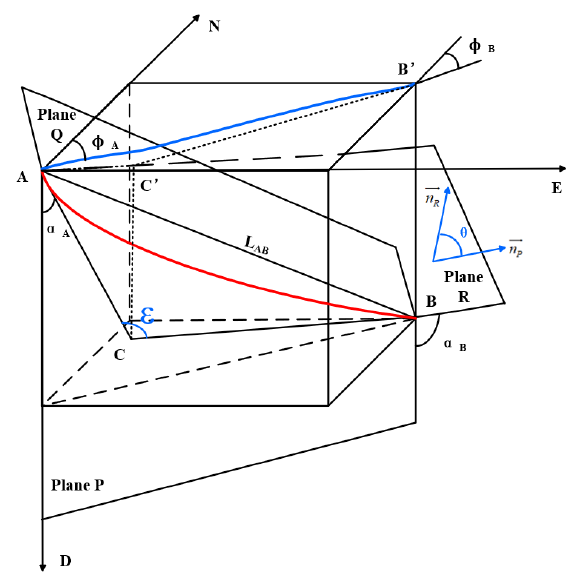
Fig. 2. Mechanical model of BH-PDM-D BHA